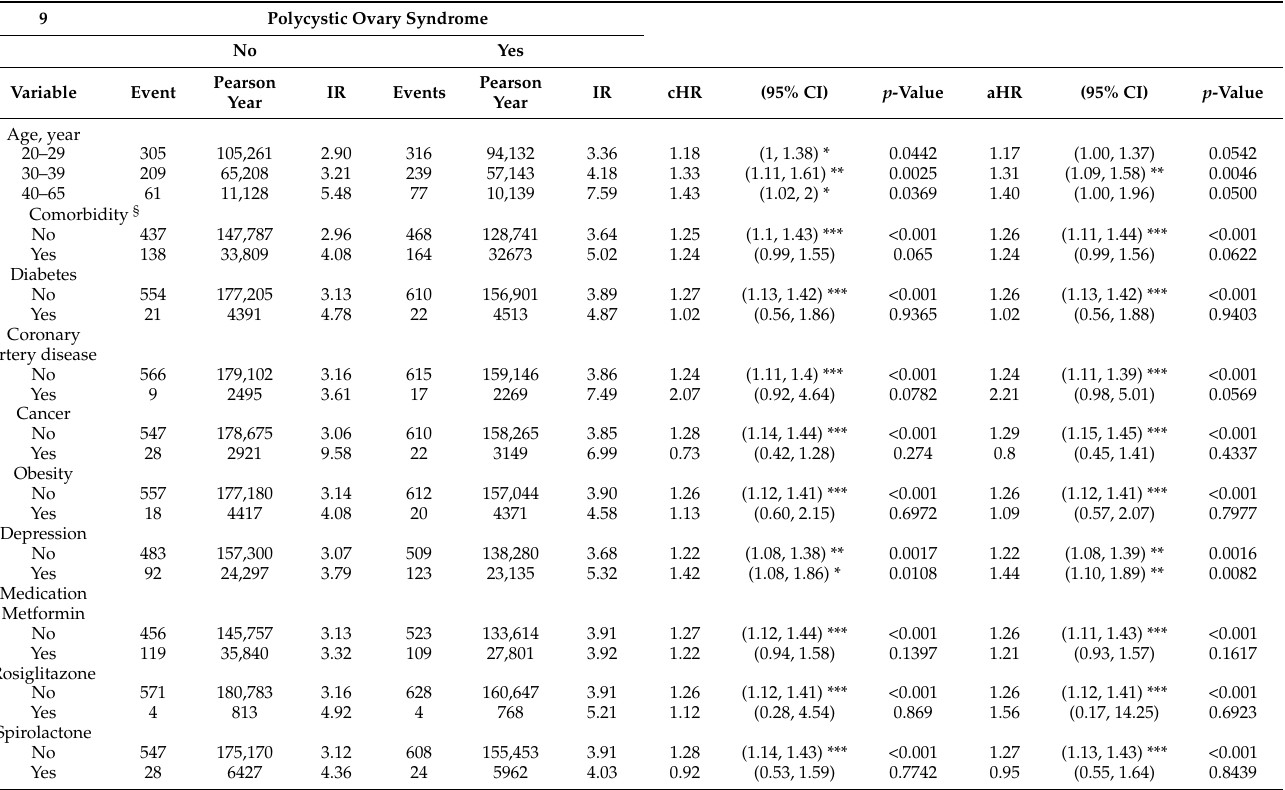
Table 3. Cox model with hazard ratios and 95% confidence intervals of herpes zoster associated patients stratified by polycystic ovary